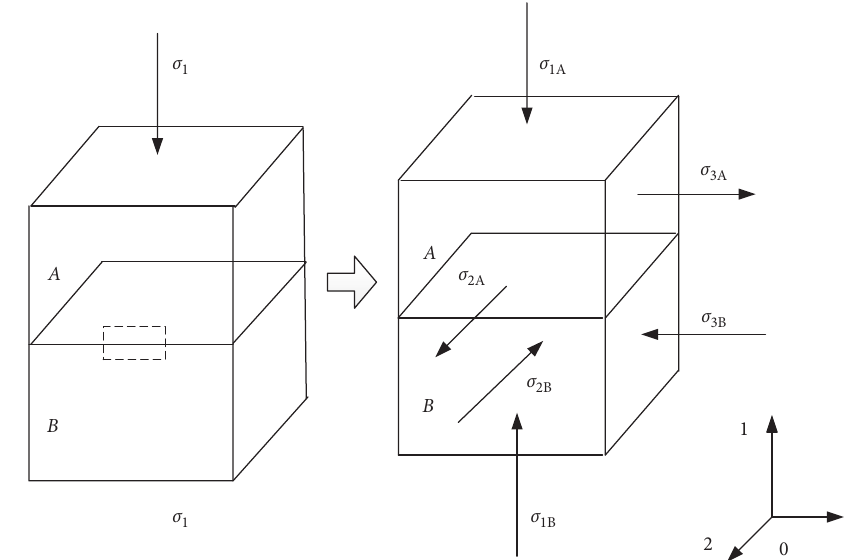
Figure 1: Force sketch map of the elastic